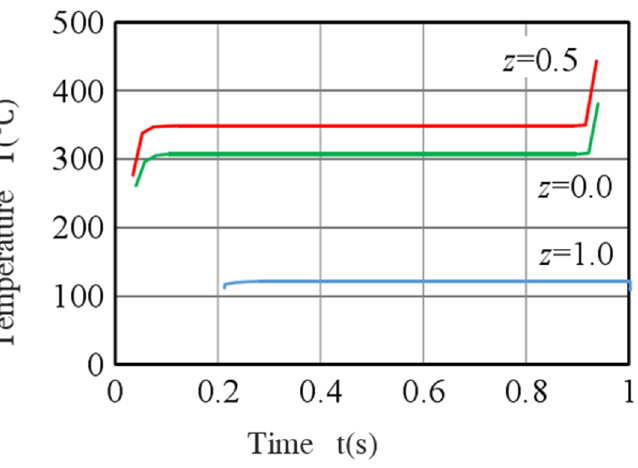
Figure 4. Historical maximum temperature curves of each point on the upper boundary layer, the outer surface of the glass layer, and the outer surface of the silicon layer of the scan line.